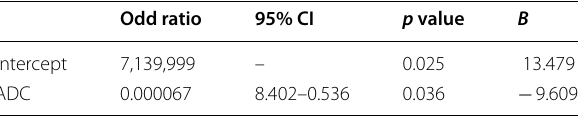
Table 6 Logistic regression for the best model (ADC) for predicting post‑TACE viable